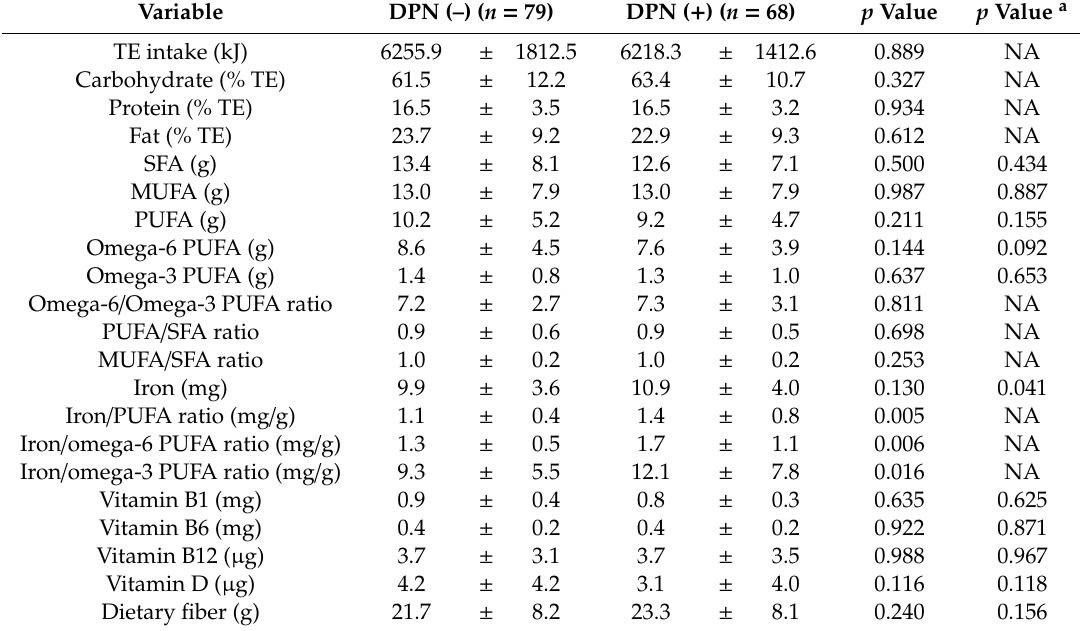
Table 2. Mean daily intake of energy and nutrients estimated from three-day food records according to the presence of DPN.